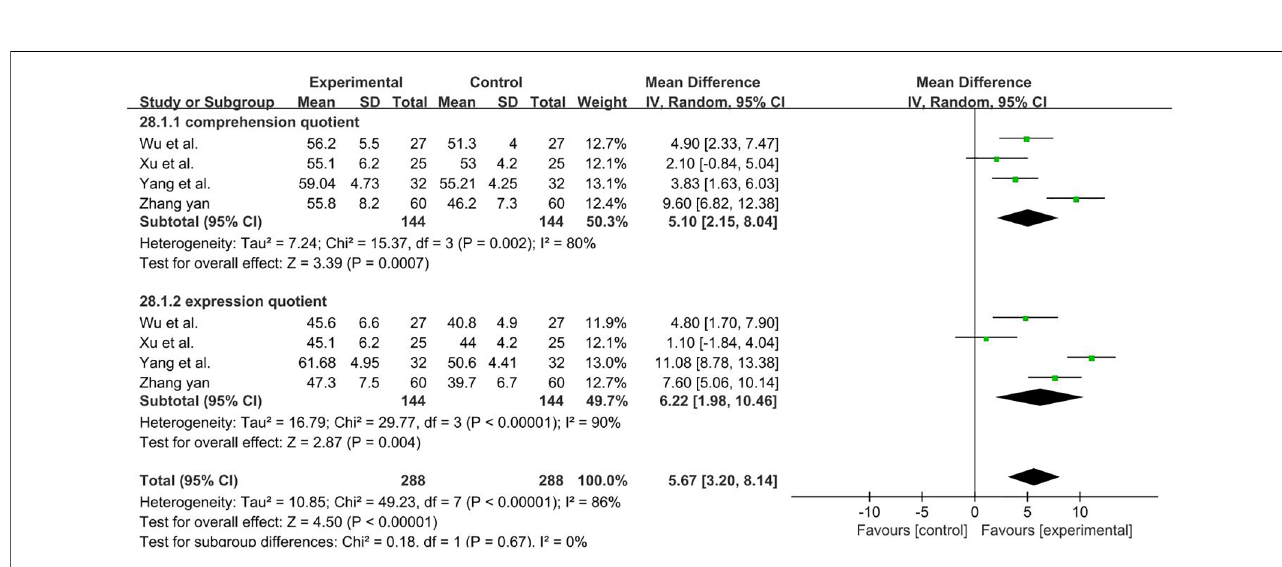
FIGURE 15 Forest plot showing MD (with 95% CI) for comprehension quotient and expression quotient of the included studies comparing the experimental and control groups. Note: Random-effect model, the result of Comprehension quotient [ I 2 =80%; MD=5.10; 95% CI (2.15, 8.04); P <0.01], the result of